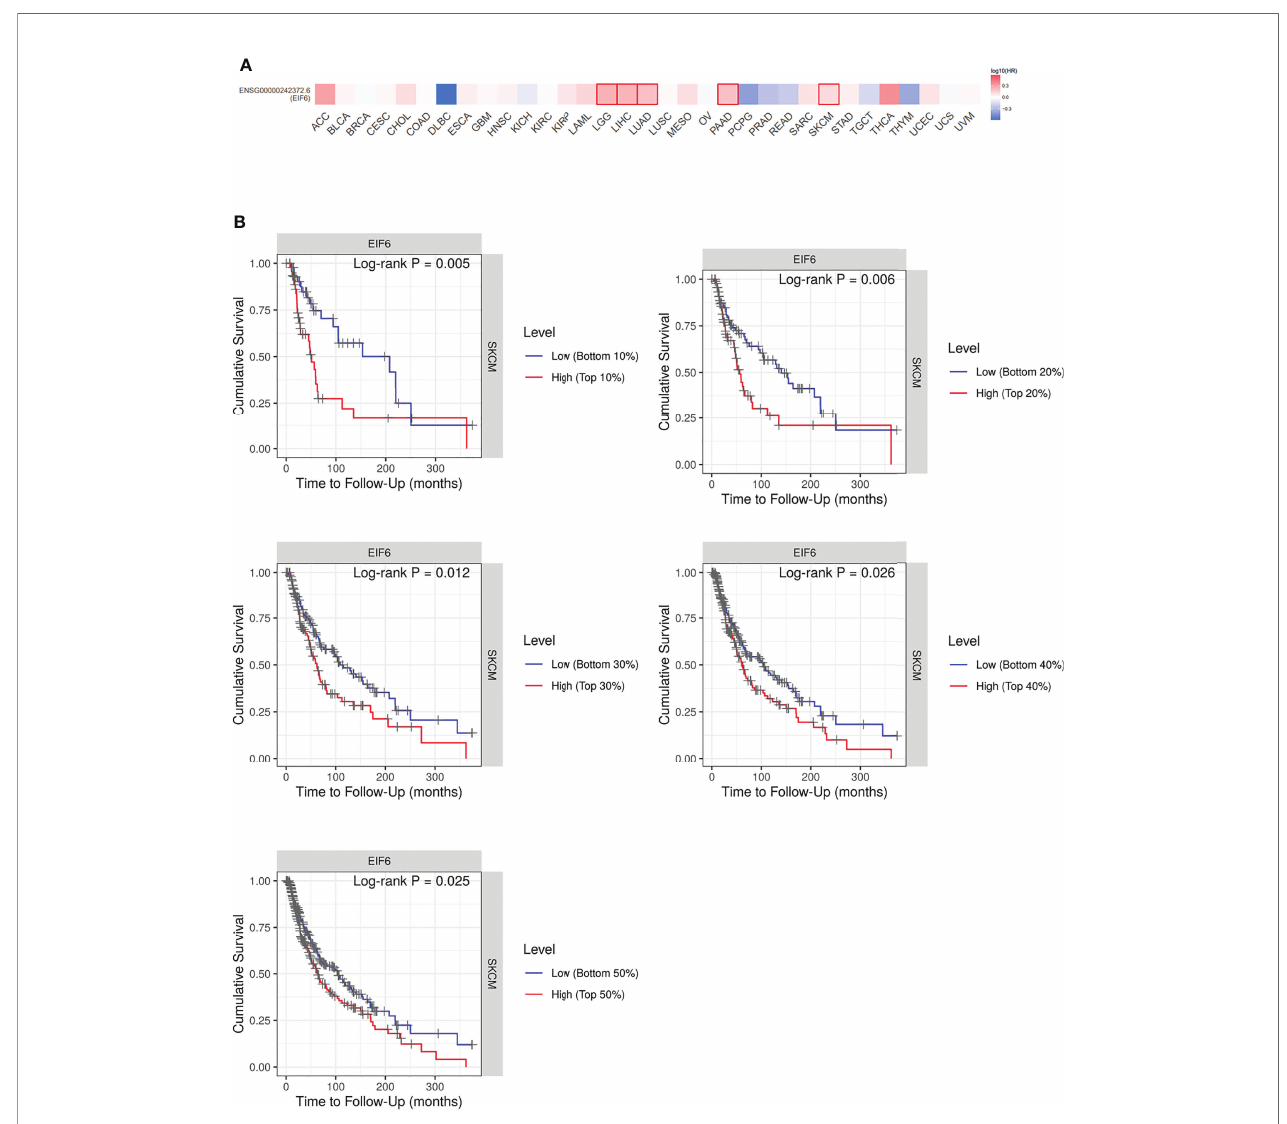
FIGURE 1 | Analysis of the correlation between cancer survival rates and eIF6 expression level. (A) Survival analysis of eIF6 in 33 types of cancers: The survival rates of 33 types of cancers were analyzed. The cancer types whose eIF6-high expressed patients showed signi fi cantly poorer prognoses were labeled with red frame. The cancer types whose survival rates were improved by high eIF6 levels were labeled with blue. (B) Melanoma patients were grouped according to their eIF6 expression levels, and their respective survival rates were